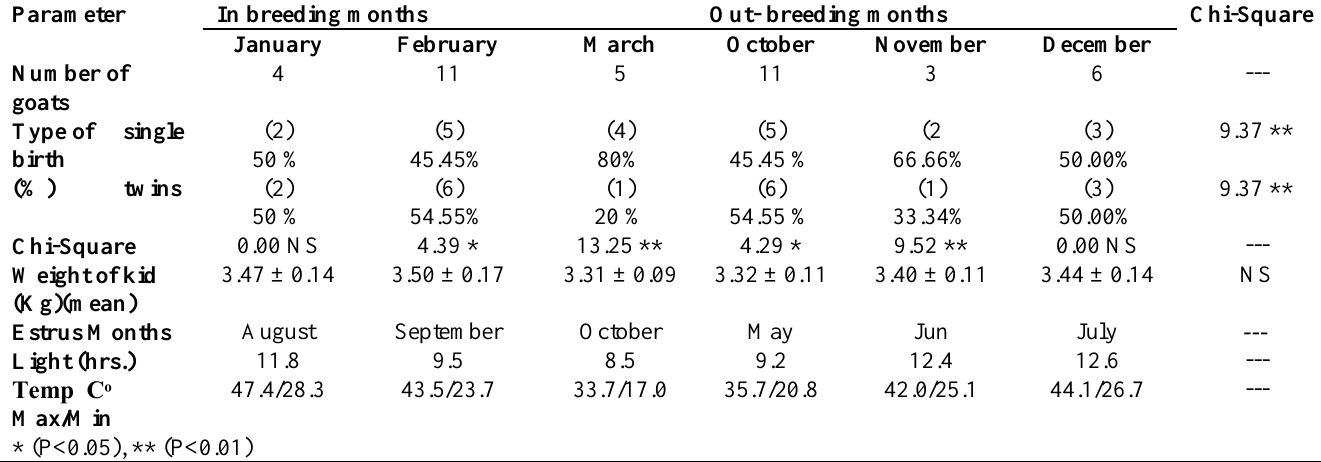
Table 1. Breeding months with number of offspring single or twins, weight of kid in local goats Parameter In breeding